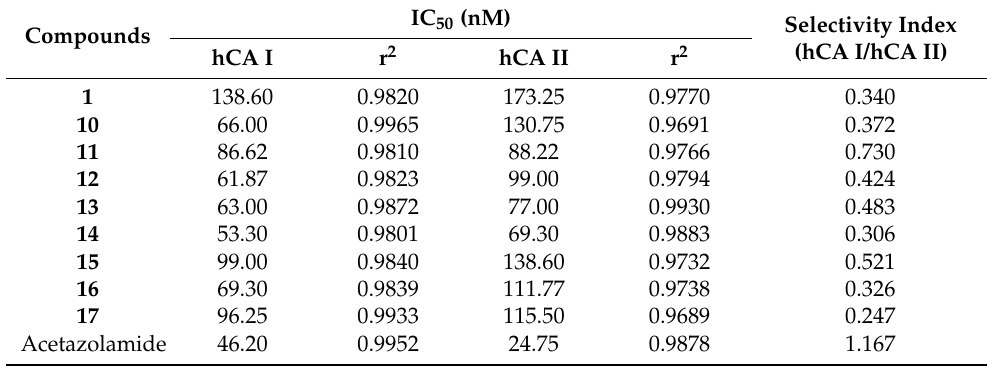
Table 3. The summarized inhibition parameters of synthesized Schiff bases ( 10 – 15 ) and hydrazineyli- dene derivatives ( 16 and 17 ) towards human carbonic anhydrase I and II isoforms (hCA I and II). Compounds